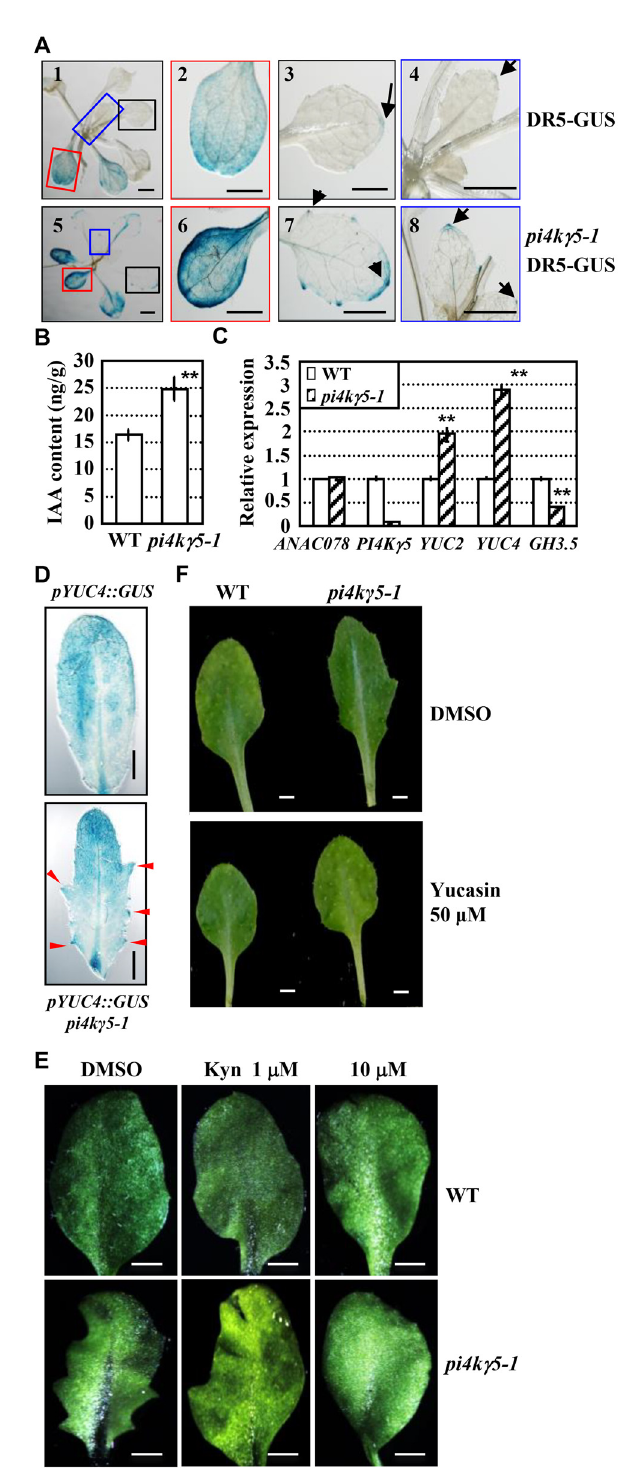
Fig 4. PI4K γ 5 deficiency results in enhanced auxin biosynthesis. A. Detection of GUS activity in DR5-GUS and pi4k γ 5 – 1 DR5-GUS lines. Arrows highlight the auxin accumulation at tip of leaf serration and top of leaf. At least 20 lines were analyzed and representative images were shown. Cotyledon (2, 6), 3 rd rosette leaf (3, 7), and 5 th rosette leaf (4, 8) of whole plant (1, 5) are shown. Bars = 1 mm. B.